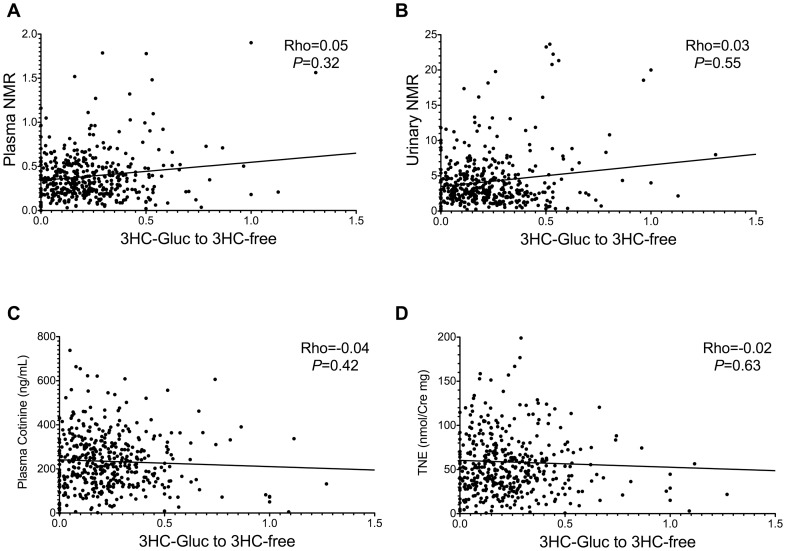
The urinary 3HC-Gluc over 3HC-free ratio did not correlate NMR or nicotine consumption.The urinary 3HC-Gluc over 3HC-free ratio did not correlate with either plasma NMR (A) or urinary NMR (B). The urinary 3HC-Gluc over 3HC-free ratio also did not correlate with either plasma cotinine (C) or the urinary TNE (D).